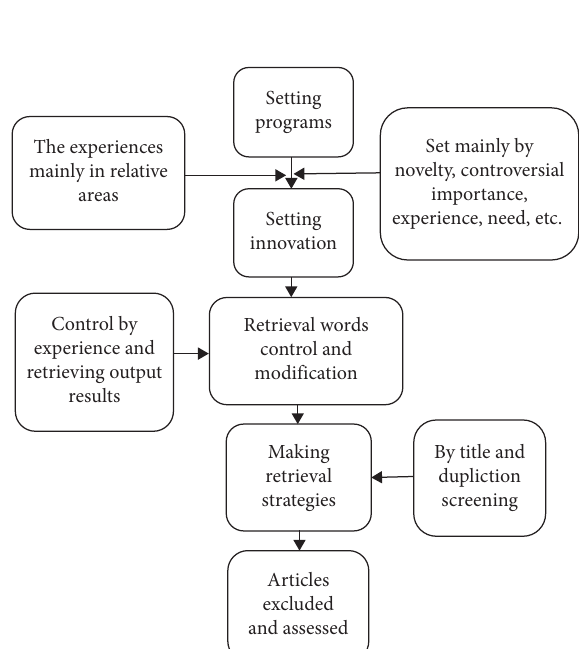
Figure 3: The conventional flow of retrieval information for meta- analyses.